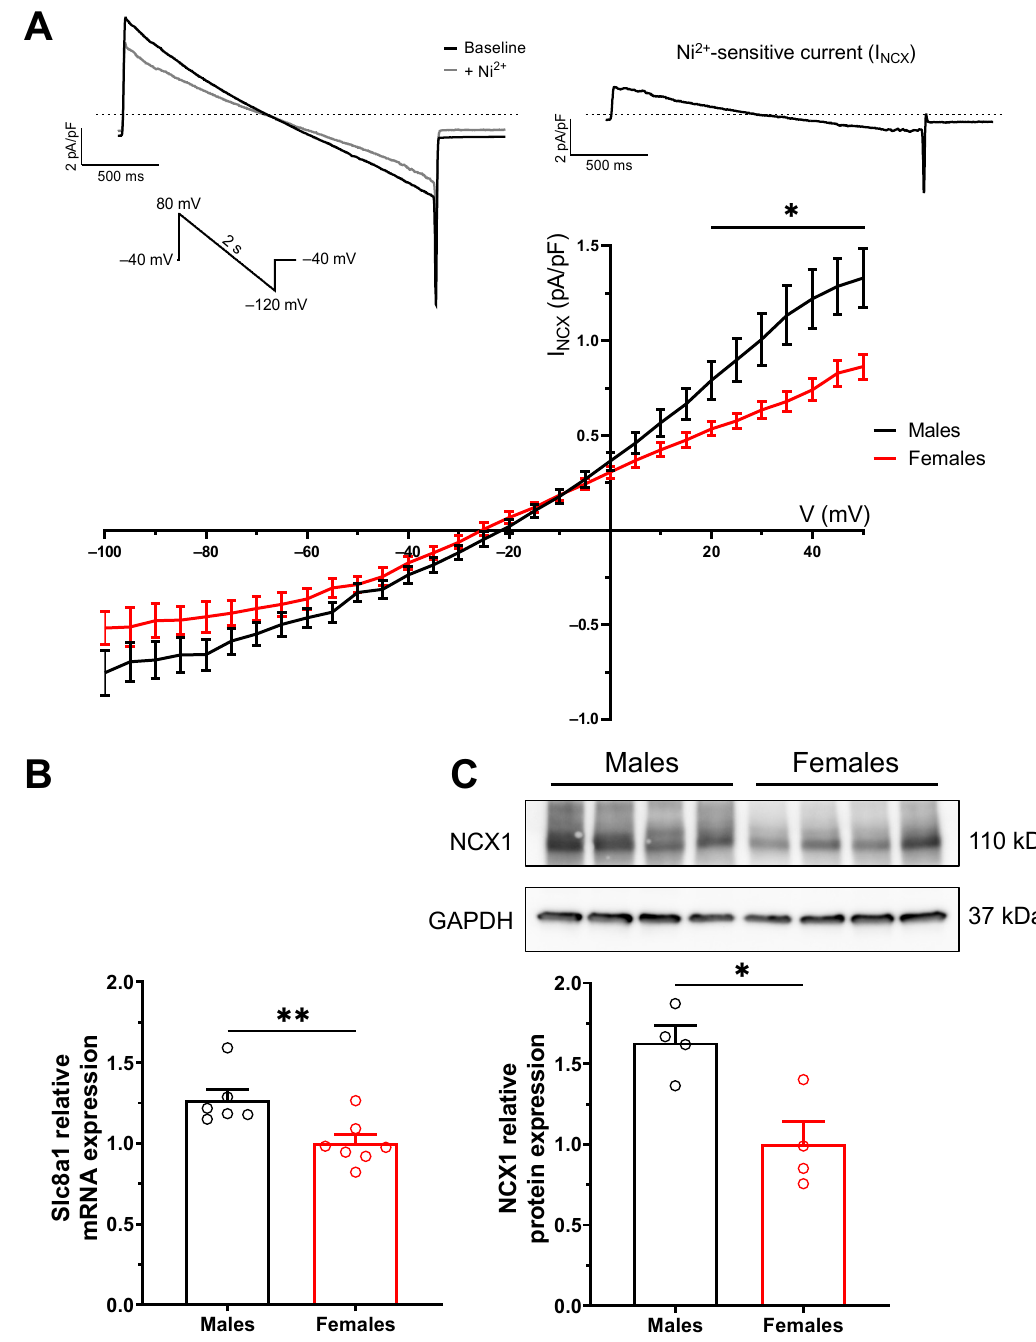
Figure 4. Higher I NCX and NCX1 expression in male atria than in females. ( A ) Top left: Typical recording in baseline conditions (black) and following inhibition of NCX1 with 5 mM NiCl (grey). Voltage protocol is shown in inset. Top right: Typical example of the nickel-sensitive subtracted I NCX . Dotted line represents the zero-current. Bottom: Mean IV curves of I NCX show larger current density in males than females (* p ˂ 0.05 from +20 to +50 mV; M: n = 18–19, N = 3; F: n = 13, N = 3). ( B ) Scatter plot shows a higher mRNA expression of Slc8a1 (coding for NCX1) in males than in females (M: 1.27 ± 0.07, n = 6; F: 1.00 ± 0.05, n = 7; ** p = 0.009). ( C ) Western blot of NCX1 in male and female left atria and their respective loading control GAPDH. Densitometry analysis revealed a higher expression of NCX1 in males (M: 1.63 ± 0.10, n = 4; F: 1.00 ± 0.14, n = 4; 2 left atria/n; * p = 0.01). * p < 0.05, ** p < 0.01